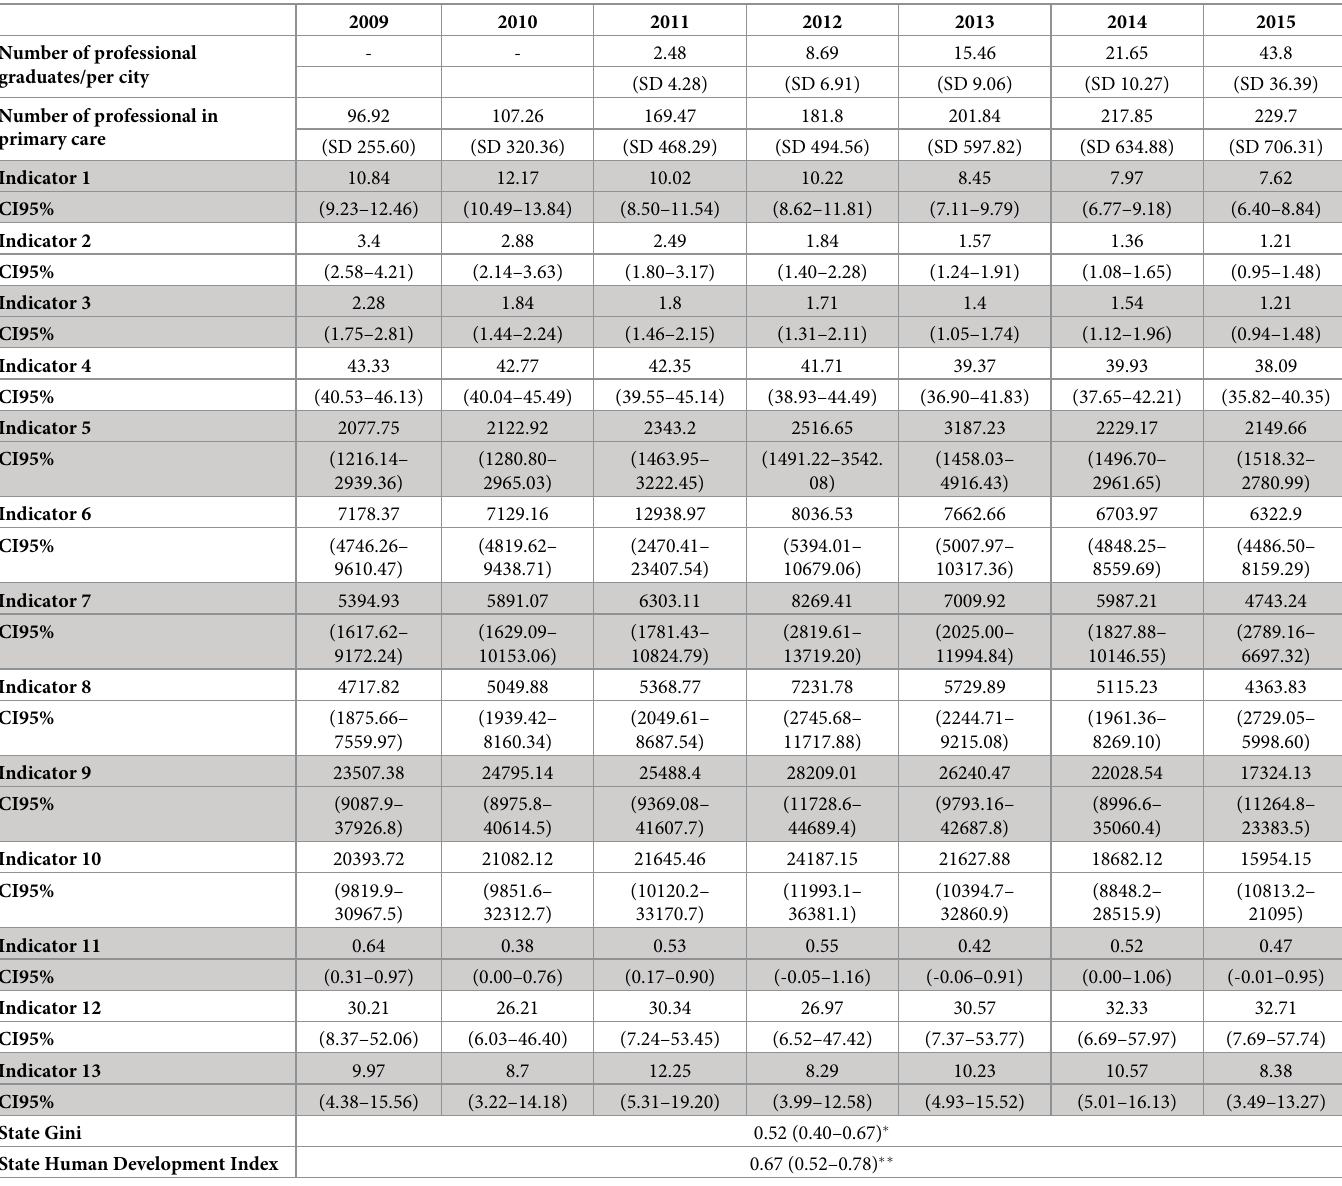
Table 1. Distribution of professional graduates and in PHC and health indicators (mean and CI95%) in Mato Grosso do Sul